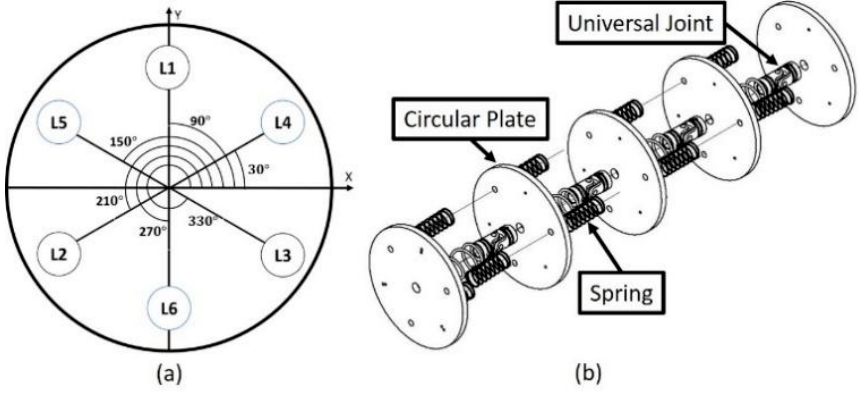
Figure 3. ( a ) Position of the compression springs and tension cables; ( b ) composition of a CKM.